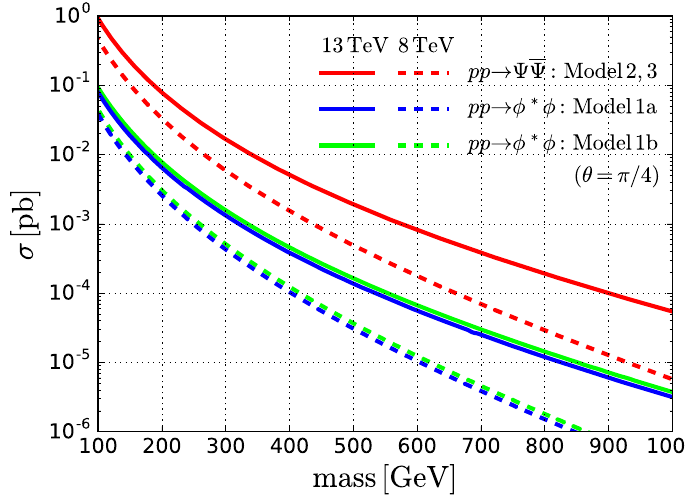
Figure 3 . Collider cross-section (cid:27) LO ( pp (cid:17) + (cid:17) (cid:0) ) for the simpli(cid:12)ed models de(cid:12)ned in table 1. ! plotted in (cid:12)gure 3 as the function of the co-annihilation partner mass. It can be seen